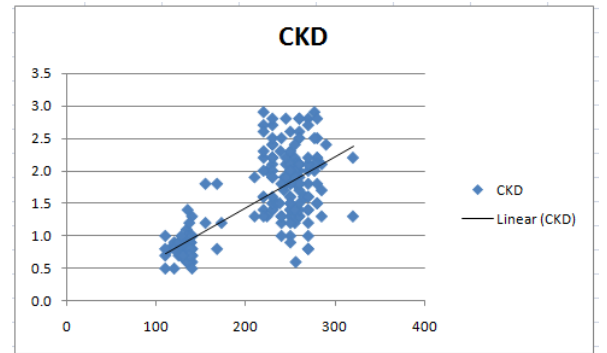
Figure 7. ROC Curve for C4.5 decision tree